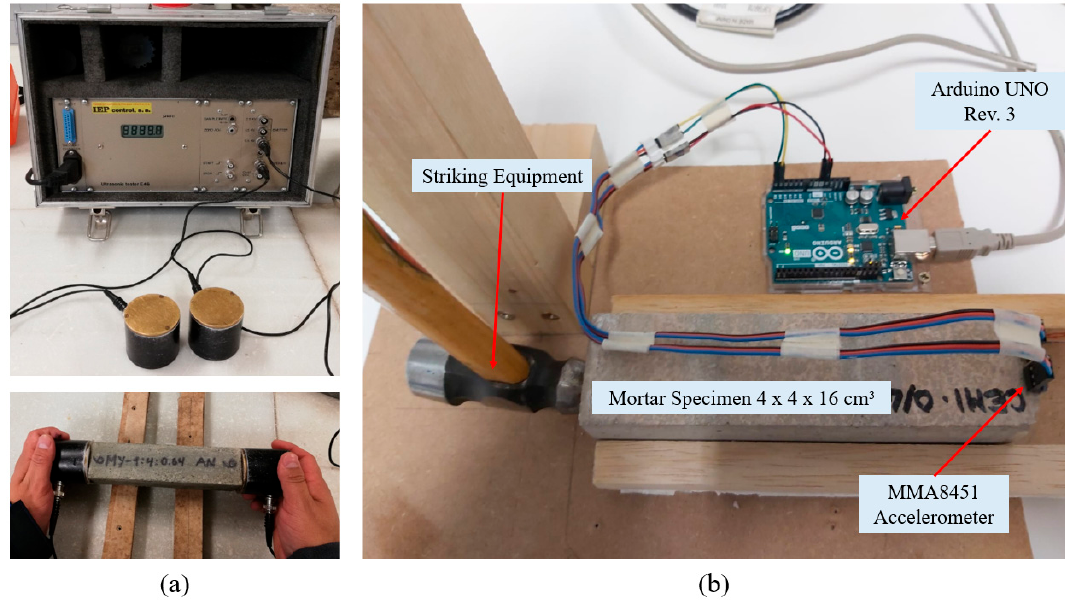
Figure 2. ( a ) Ultrasonic tester E46 measurement equipment and taking of measurements; ( b ) measurement equipment implemented in Arduino.